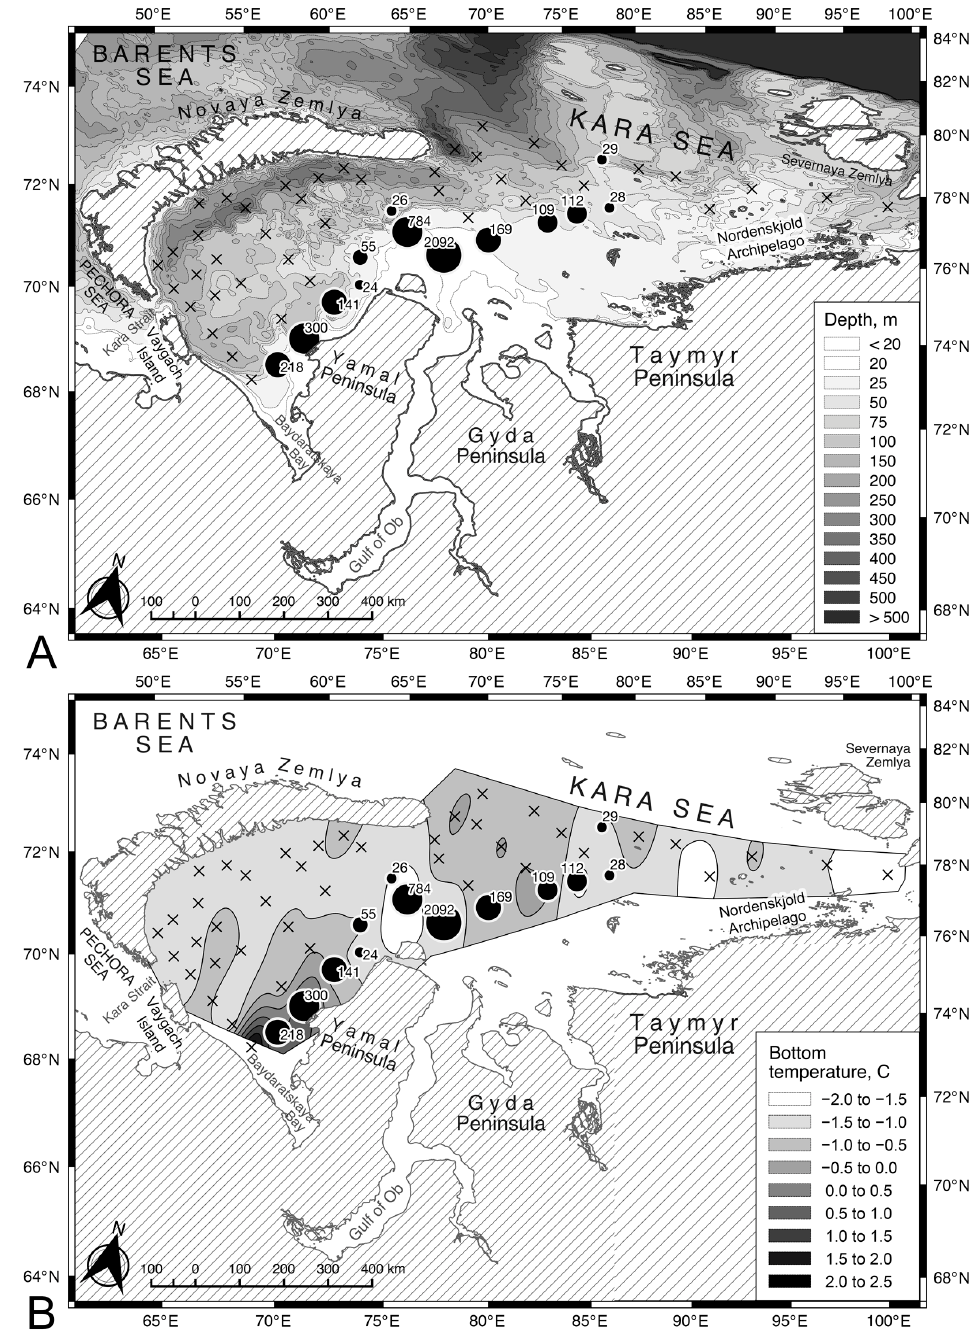
Figure 2. Spatial distribution of ribbed sculpin Triglops pingelii depending on depth ( A ) and bottom temperature ( B ) in the Kara Sea, September 2019.